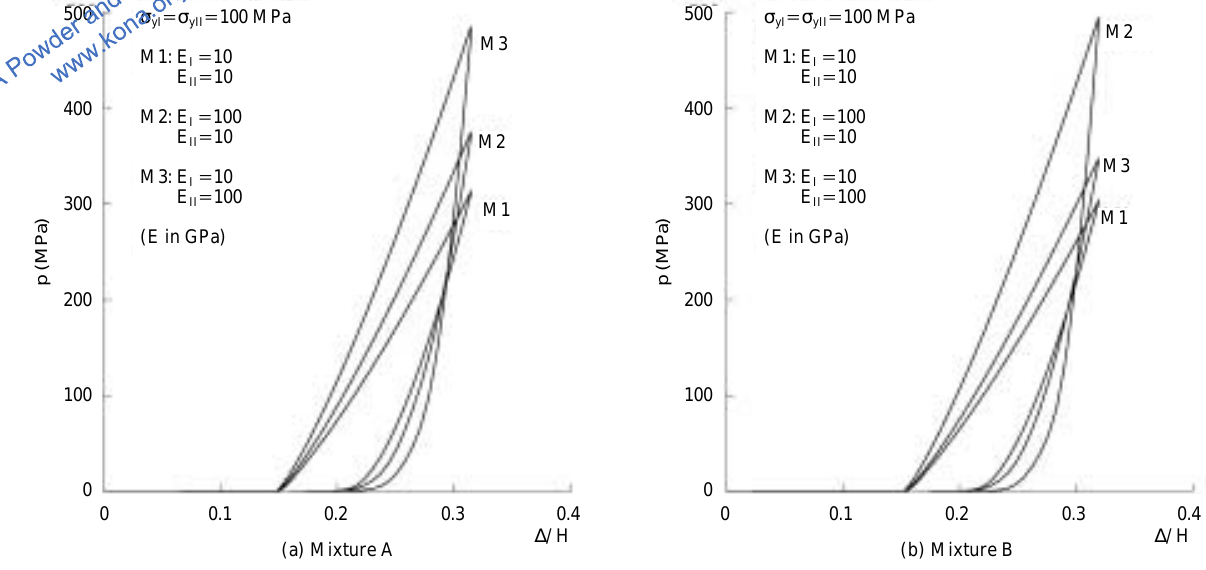
The global pressure-deformation responses of both mixtures at a various of combinations of Young’s moduli.